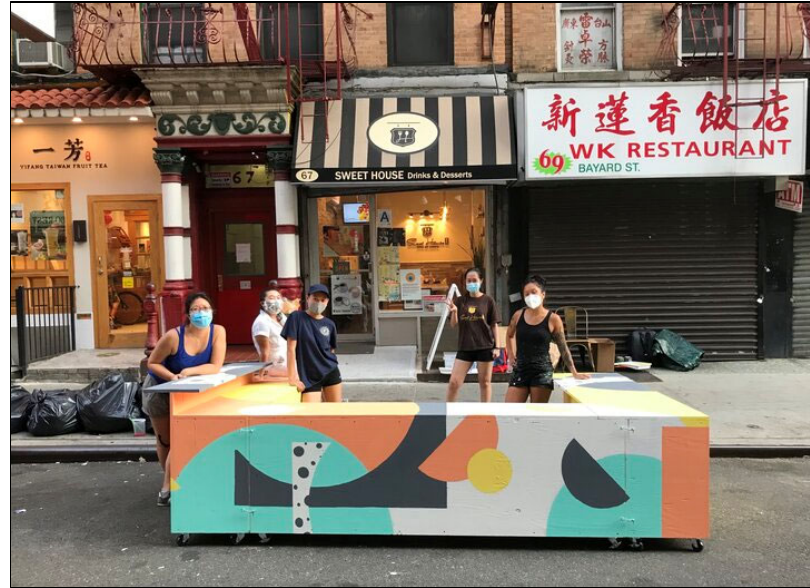
Figure 1. Think!Chinatown and women-led design studio A+A+A build new outdoor dining to support Sweet House Drinks & Desserts on 67 Bayard Street in their program Assembly for Chinatown. Photo by